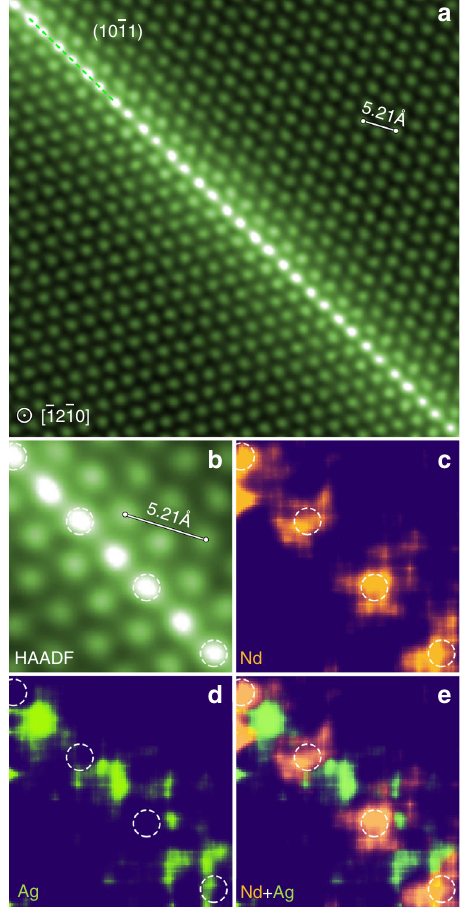
Fig. 2 Alternating distribution of Nd and Ag atoms in a 10 (cid:1) 11 ð Þ twin boundary. a Atomic-resolution HAADF-STEM image viewed along (cid:1) 12 (cid:1) 10 ½ (cid:2) . b Enlarged image of a region in ( a ). c – e Corresponding atomic-resolution EDS maps showing atomic columns rich in c Nd, d Ag and e (Nd + Ag). Dashed circles in ( b – e ) indicate extension